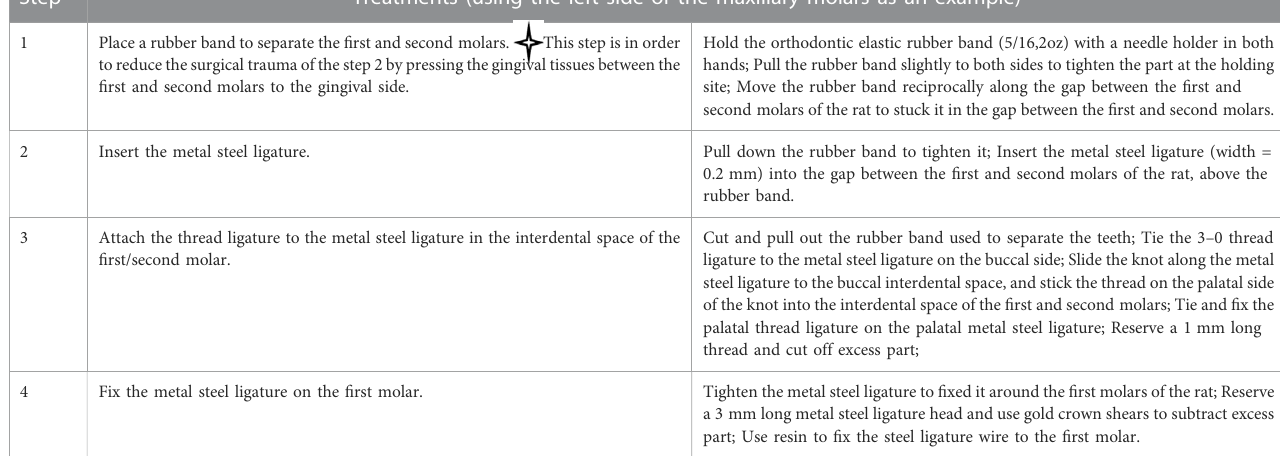
TABLE 1 Detailed procedure of the modi fi ed method to induce experimental periodontitis. Step Treatments (using the left side of the maxillary molars as an example) Place a rubber band to separate the fi rst and second